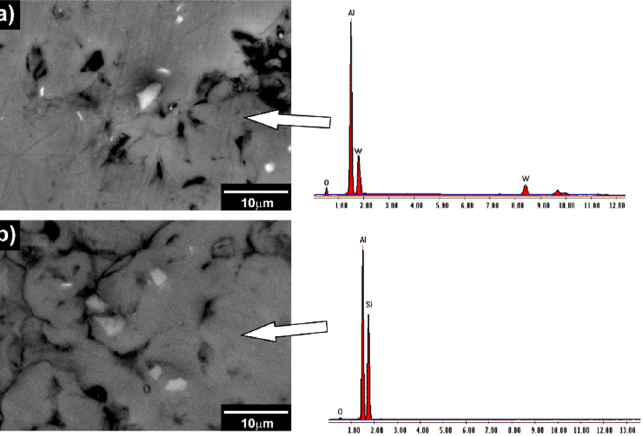
Figure 5. EDX made in samples sintered at 600 °C for 1 h, ( a ) composite of the matrix Al-0.5 vol.% WC and ( b ) composite of the matrix Al-0.5 vol.% mullite.